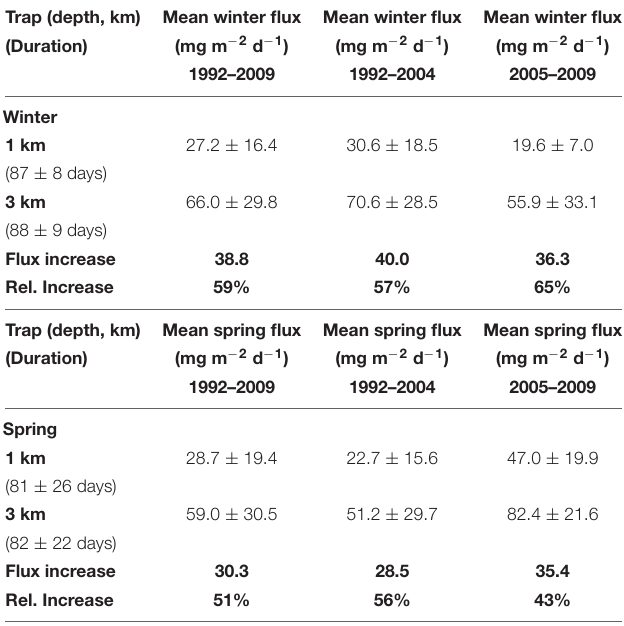
TABLE 2 | Daily mean total fluxes (in mg m − 2 d − 1 with the standard deviations) for traps deployed in the Canary Basin for winter and spring seasons averaged over different yearly